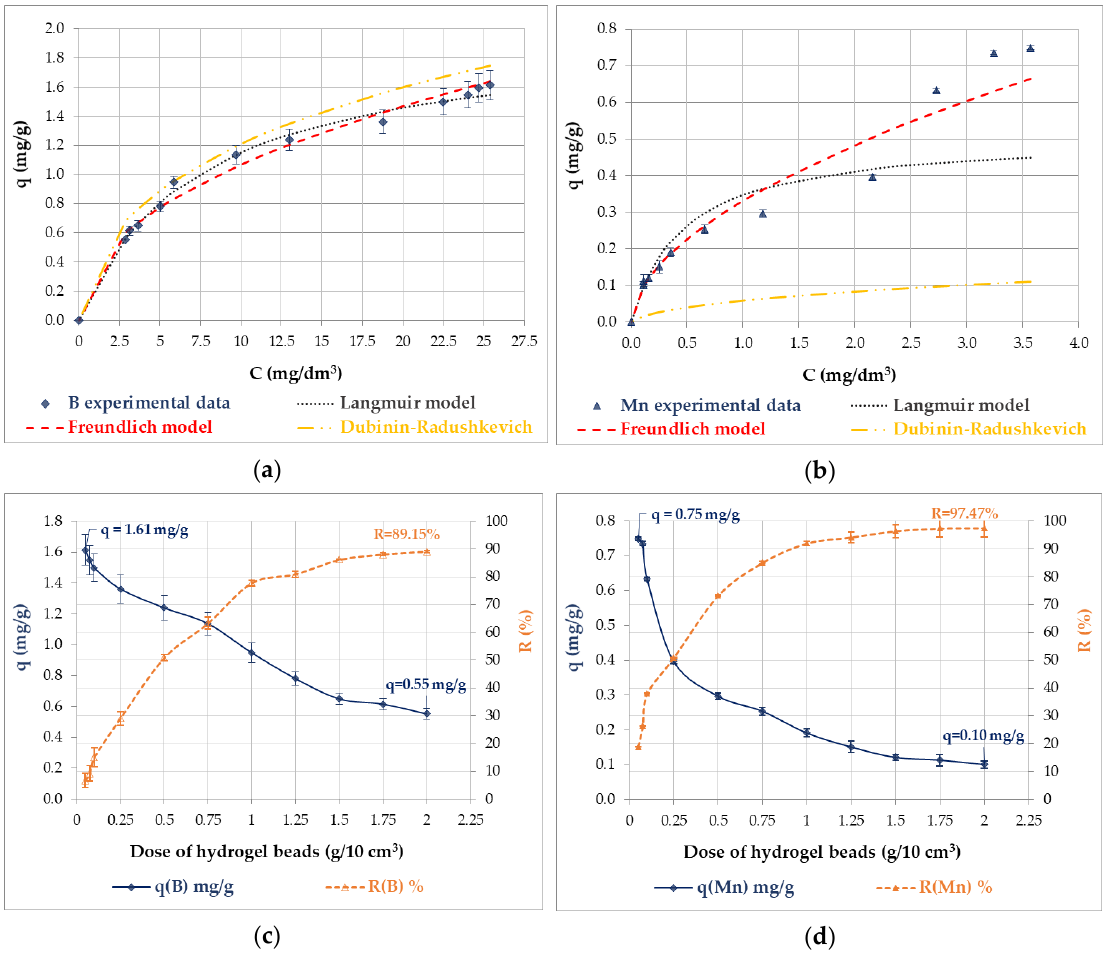
Figure 1. Boron ( a ) and manganese ( b ) adsorption isotherms on hybrid chitosan-zirconium hydrogel beads: experimental curves, Langmuir, Freundlich, and Dubinin–Radushkevich models, and the effect of hybrid chitosan-zirconium hydrogel bead amount on boron ( c ) and manganese ( d ) adsorption.